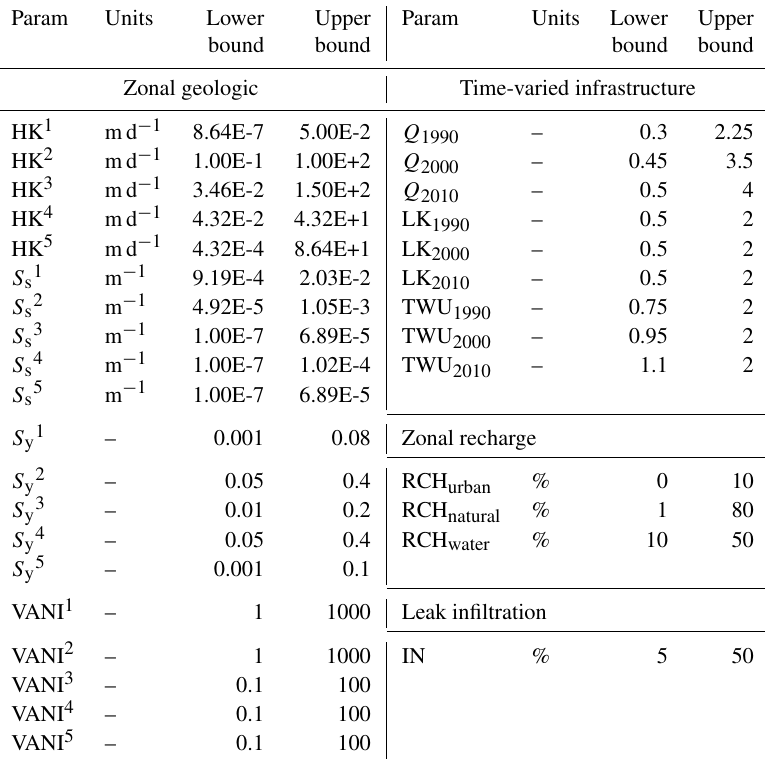
Table 1. Model parameters and sampling ranges. Param Units Lower